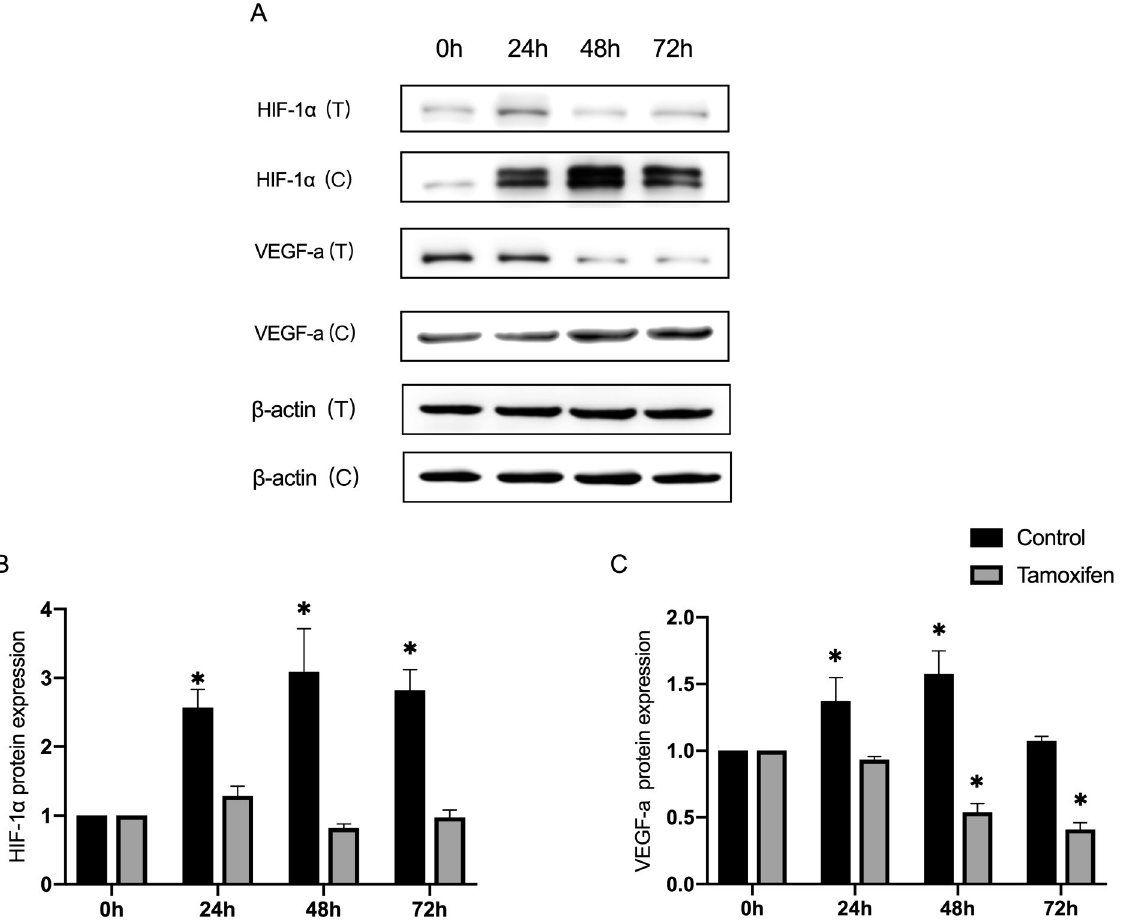
Fig 4. The hypoxia-treated ECs were incubated with tamoxifen, the HIF-1 α inhibitor, and the expression of HIF-1 α and VEGF-a were detected. (A) The representative images from the western blot performed for the detection of HIF-1 α and VEGF-a, with and without tamoxifen treatment. (B and C) Densitometric analyses of the western blot experiments. The above experiments were repeated three times independently. The statistical differences were assessed by one-way analysis of variance (ANOVA) (Kruskal–Wallis), followed by Dunn’s posthoc test. � P < 0.05 against the untreated condition. The graph bars show the mean ± SD. The asterisk on top of the bars correlate to the 24, 48 and 72 hours, which represent the comparison with the bars at zero hour.